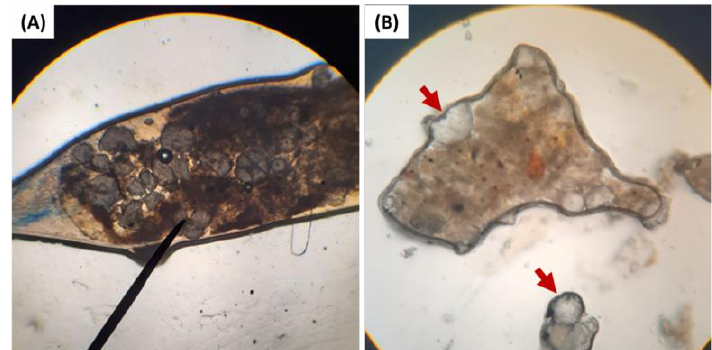
Figure 4. ( A ) The obstruction of HDPE-MP in the intestinal tract of shrimp that were fed with 20% HDPE. ( B ) HDPE-MP in excreta of HDPE-MP-fed shrimp. The red arrow indicates HDPE particles in